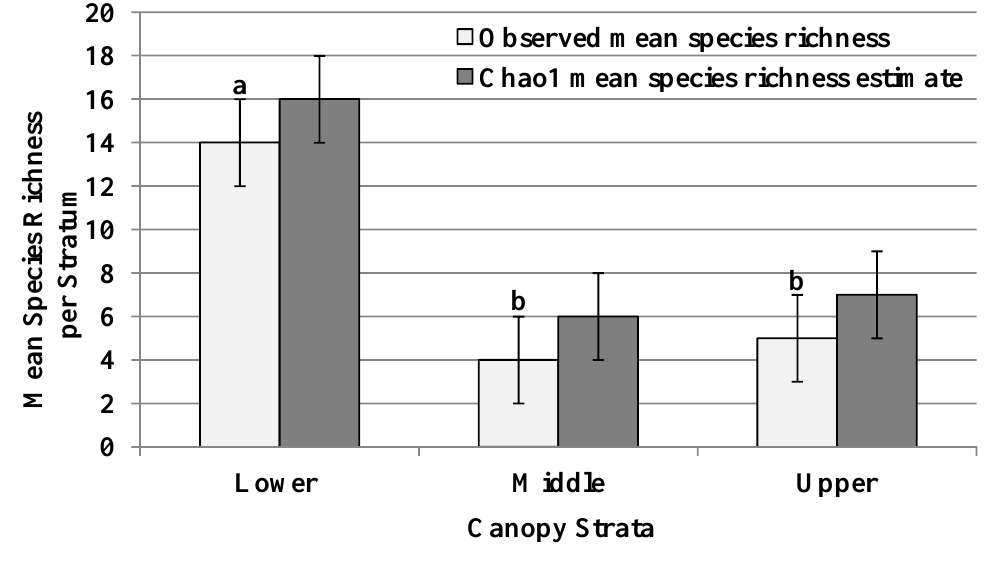
Figure 2. Observed mean species richness (mean number of species ± SE) for each stratum and Chao1 mean (±95% CL) species richness estimate. Different lower case letters above standard error bar indicate differences among strata (LSD test; p >